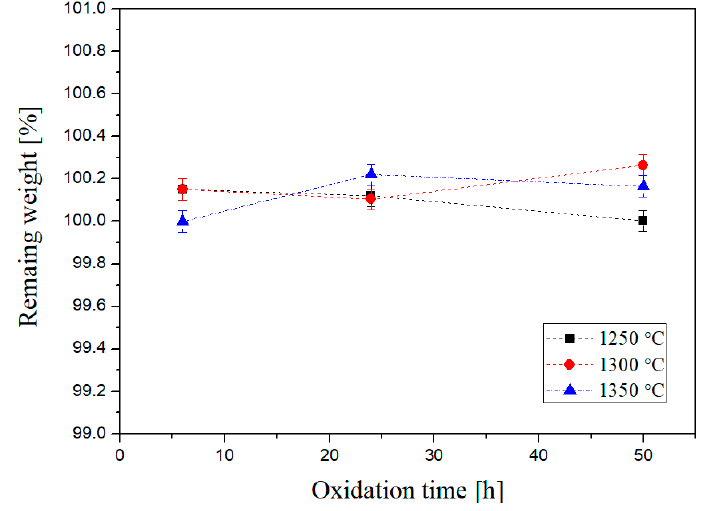
Figure 8. Remaining weight percent of TZM alloys after oxidation exposure at the designated temperature and time.